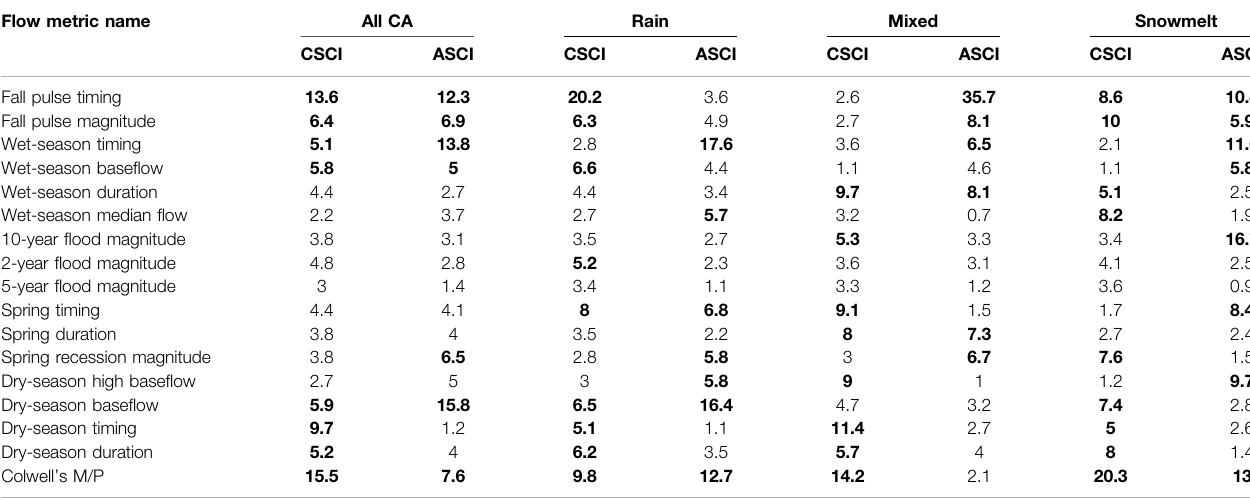
TABLE 1 | Mean relative in fl uence values for functional fl ow metrics included in four models (with data from all California and three regions based on stream class) that assessed fl ow alteration in relation to ASCI and CSCI scores. Bolded values were most in fl uential ( >